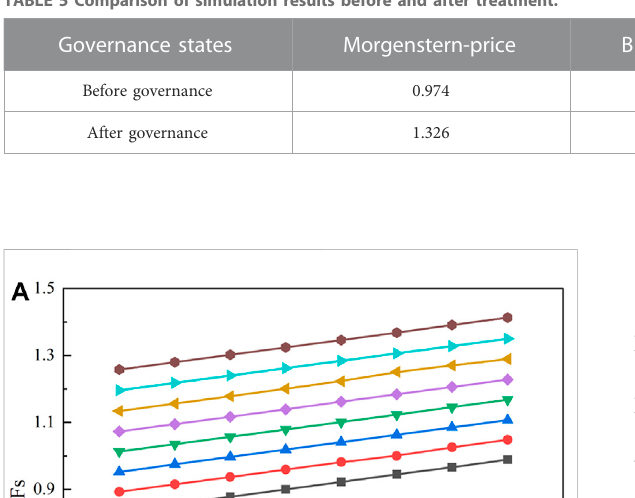
TABLE 5 Comparison of simulation results before and after